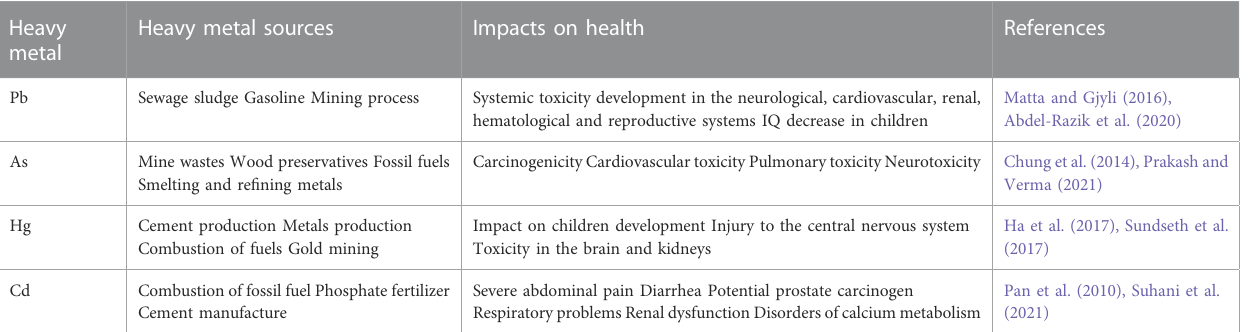
TABLE 1 Common heavy metals and their effects on health. Heavy Heavy metal metal